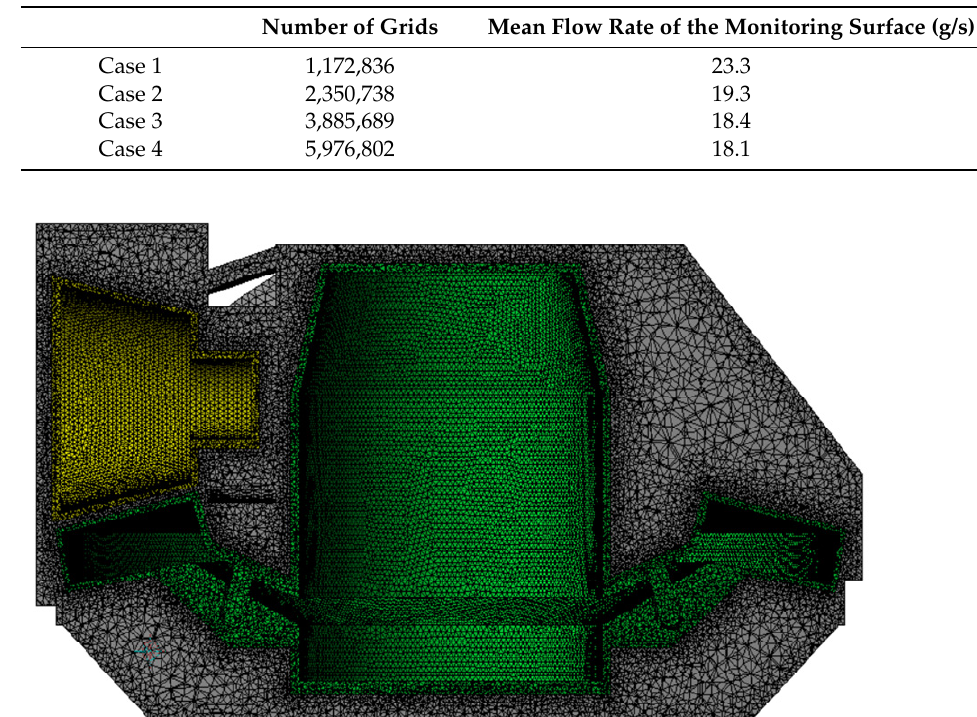
Table 1. Grid independence analysis.